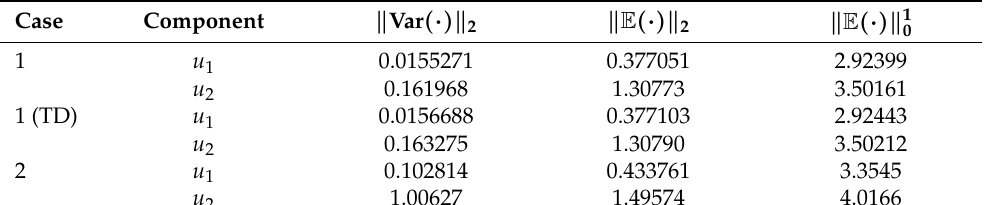
Table 1. Computed quantities of interest. As expected, the norms of the expected solutions differ only marginally, whereas the difference in variance reflects the different underlying models of material uncertainty.